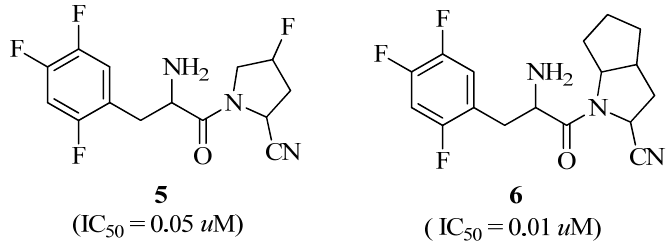
Figure 4. β -amino pyrrole-2-carbonitrile analogues.